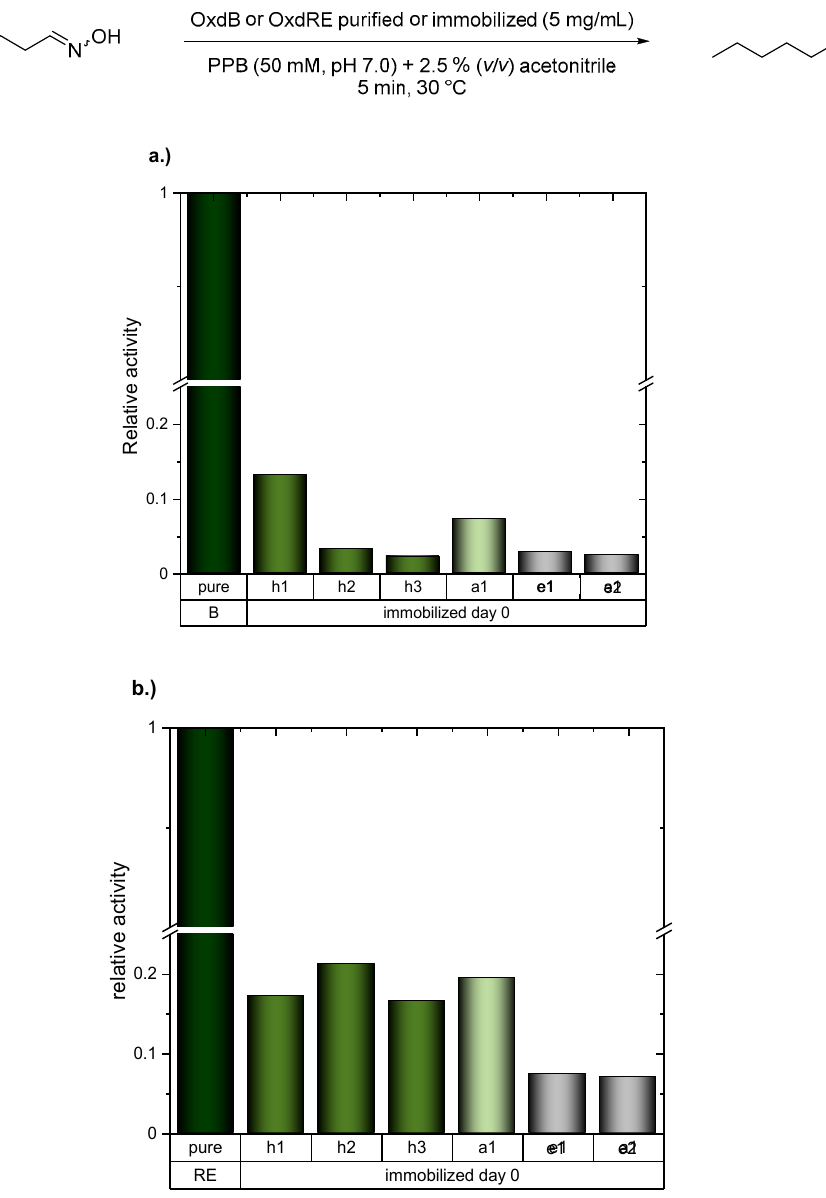
Figure 2. Residual activity of ( a ) OxdB and ( b ) OxdRE immobilizates in comparison with purified OxdB or OxdRE.